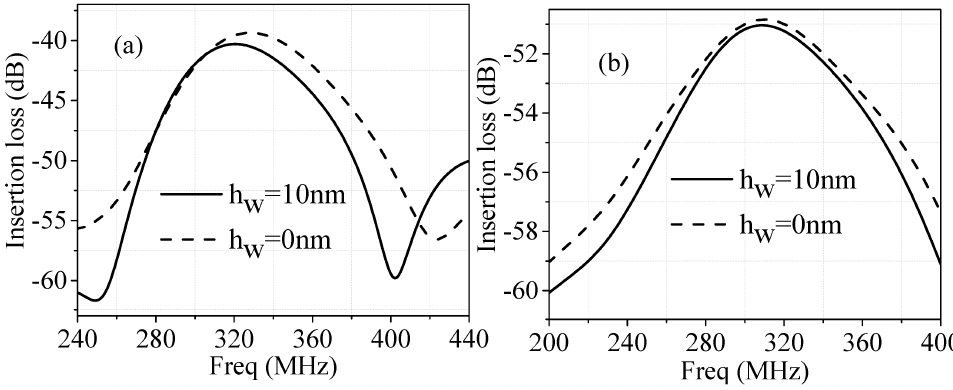
Figure 5. Frequency responses of humidity sensors: ( a ) Rayleigh wave; ( b ) Love wave.